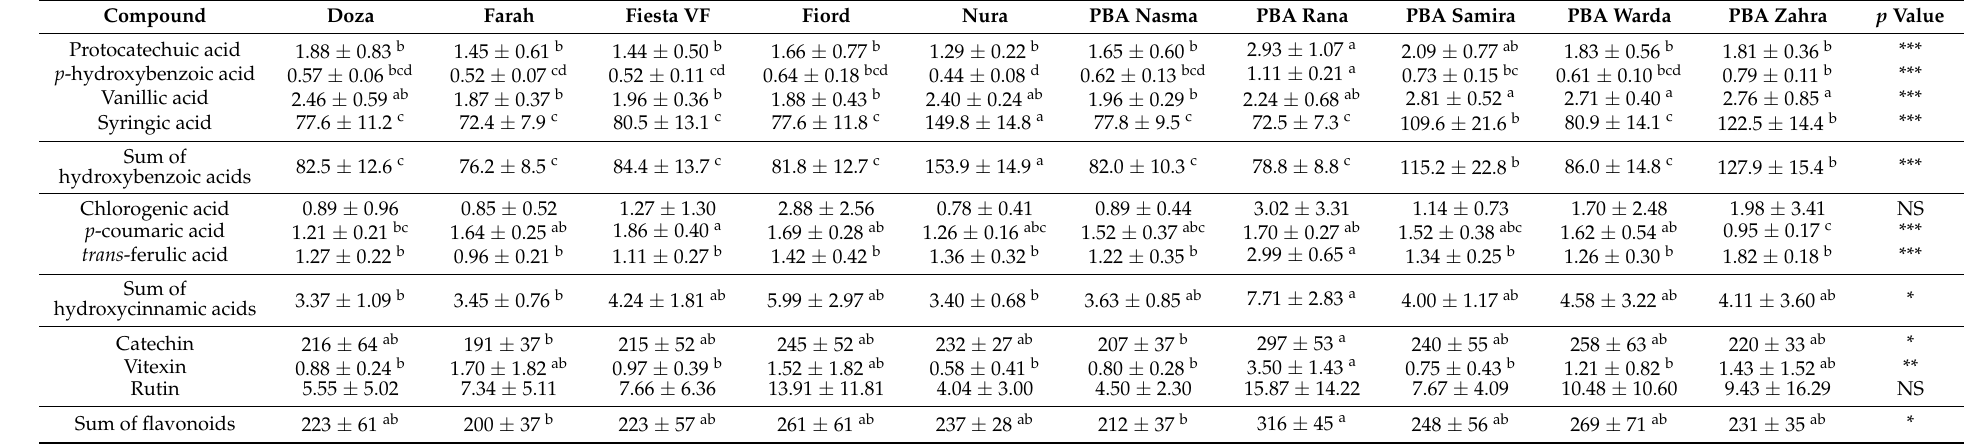
Table 1. Mean phenolic acid and flavonoid contents in the 10 faba bean varieties. Values given in µ g/g (mean ± SD from 6 replicates, comprising within-field triplicates from two field locations). p -value indicates the significance between varieties, with results obtained from a two-way ANOVA between site × variety. Note that entries in the same row containing the same superscript letter (a–d) were not significantly different from one another at α =